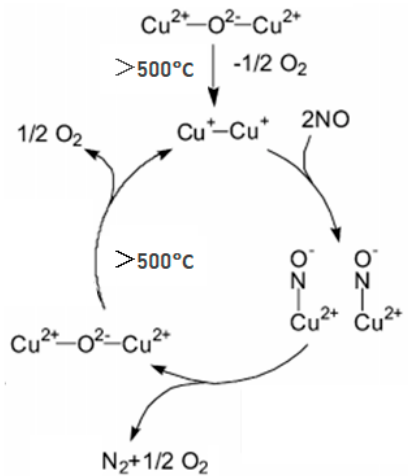
Figure 8. Proposed denitrification mechanism of the Cu-Al / SiO 2 porous material at high temperature.